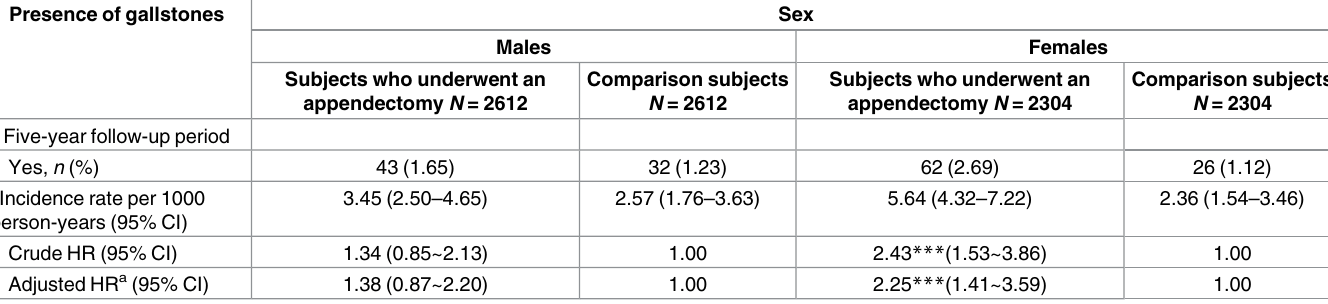
Table 3. Crude and covariate-adjusted hazard ratios (HRs) for gallstones among sampled subjects during the 5-yearfollow-up period by